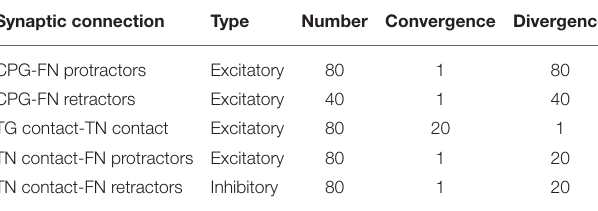
TABLE 1 | Connectivity of the SNN whisker system